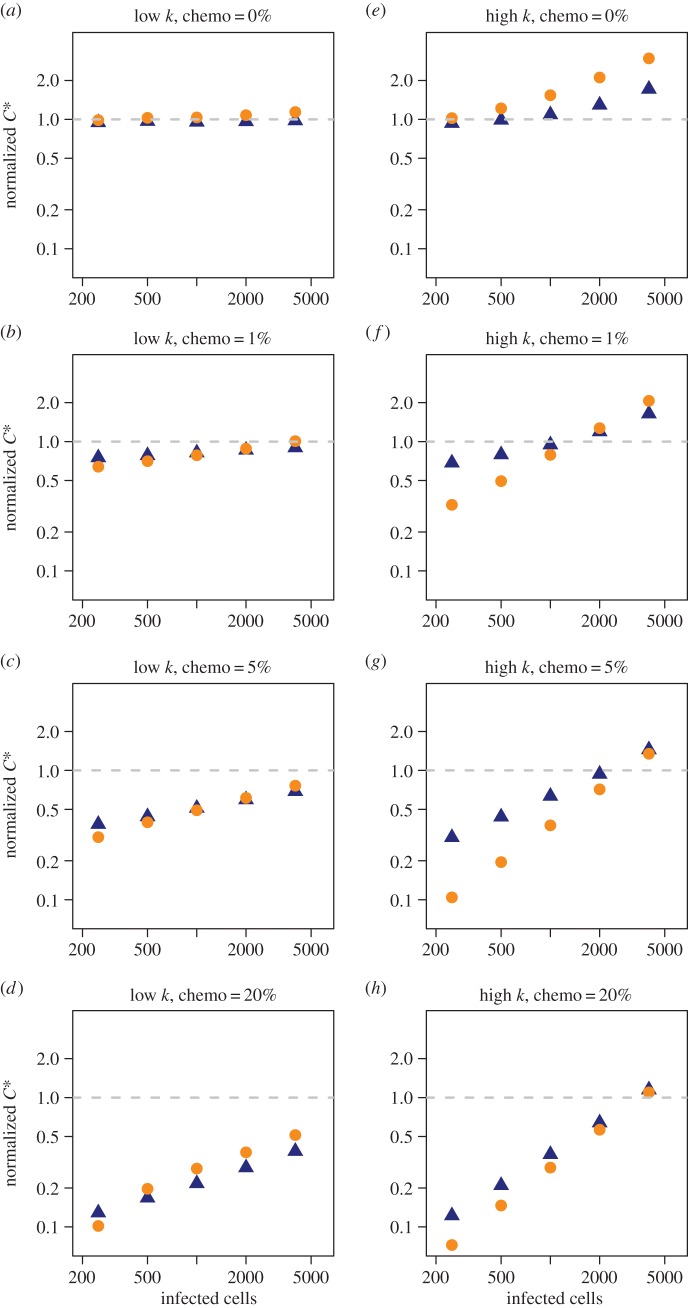
Critical CTL densities (in units of the basic mass-action estimate C*= r/k) for different levels of chemotaxis. (a–d) Slow CTL surveillance and (e–h) rapid surveillance. Blue triangles, diffuse infection; orange circles, clustered infection. Note logarithmic scale on y-axes.